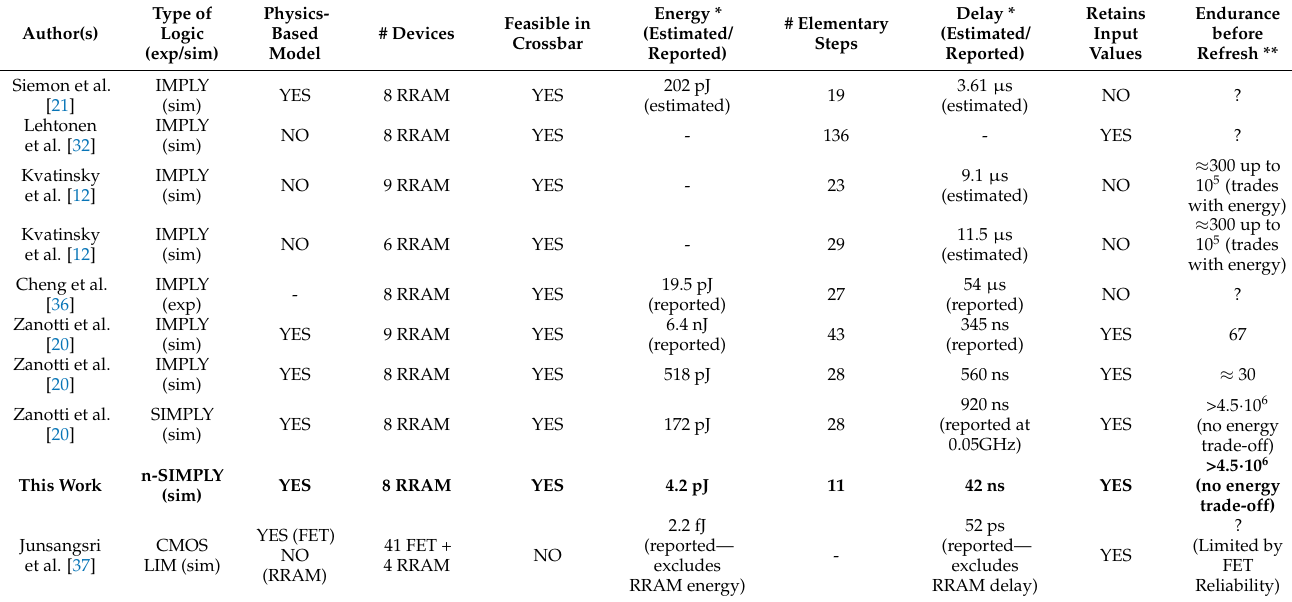
Table 4. Detailed comparison among the proposed and existing FAs in the literature. SIMPLY, IMPLY, and Hybrid-CMOS LiM solutions (both experimental and simulation works).